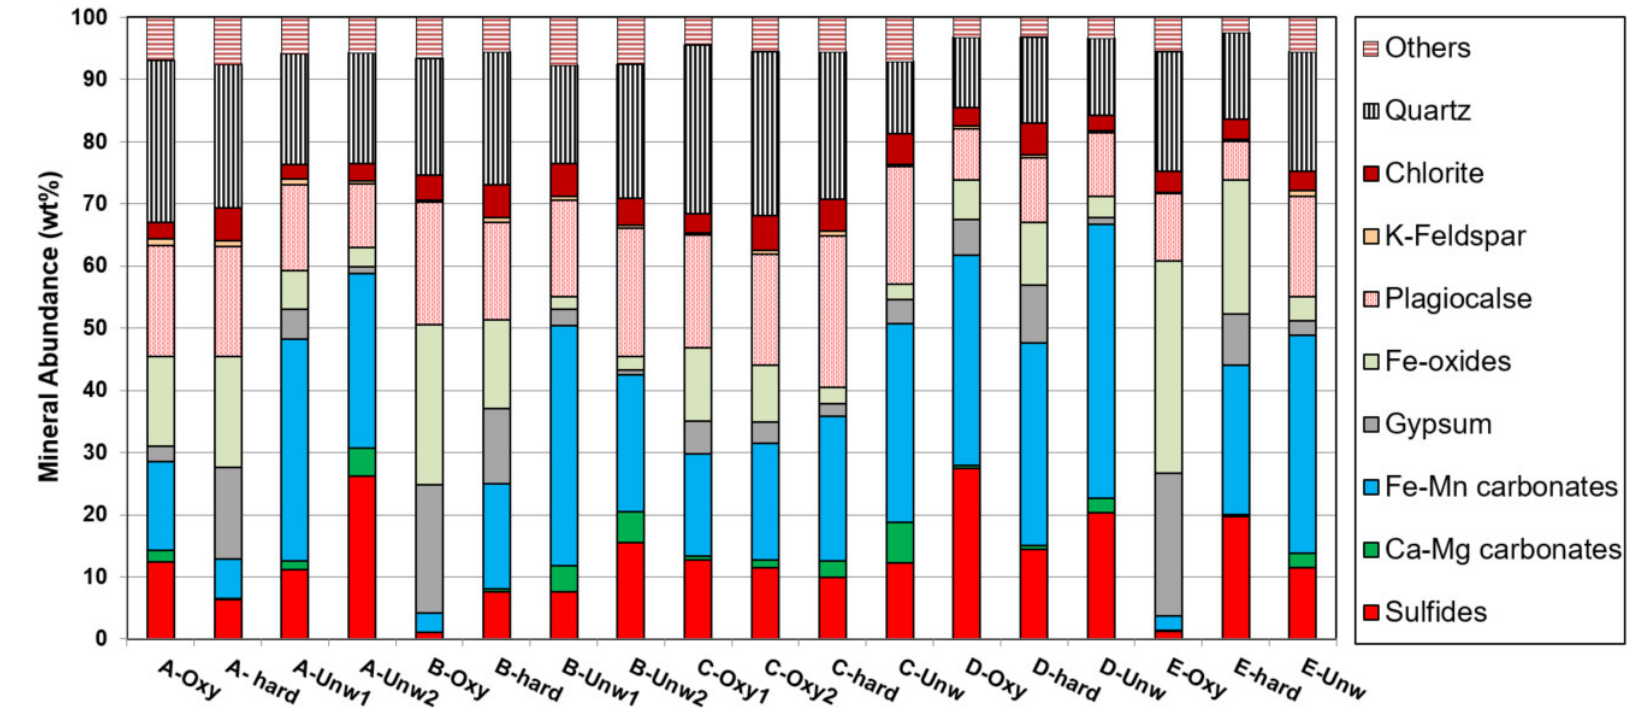
Figure 5. Mineralogical composition of the different stations’ horizons.